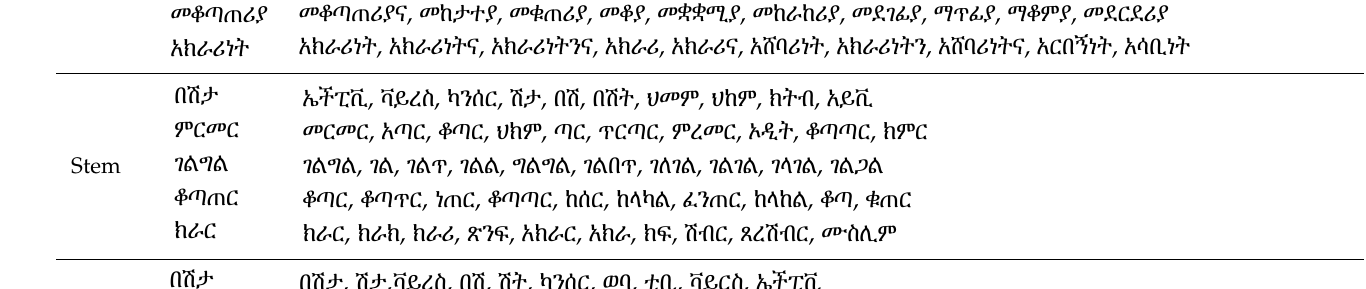
. Roots of verbs are